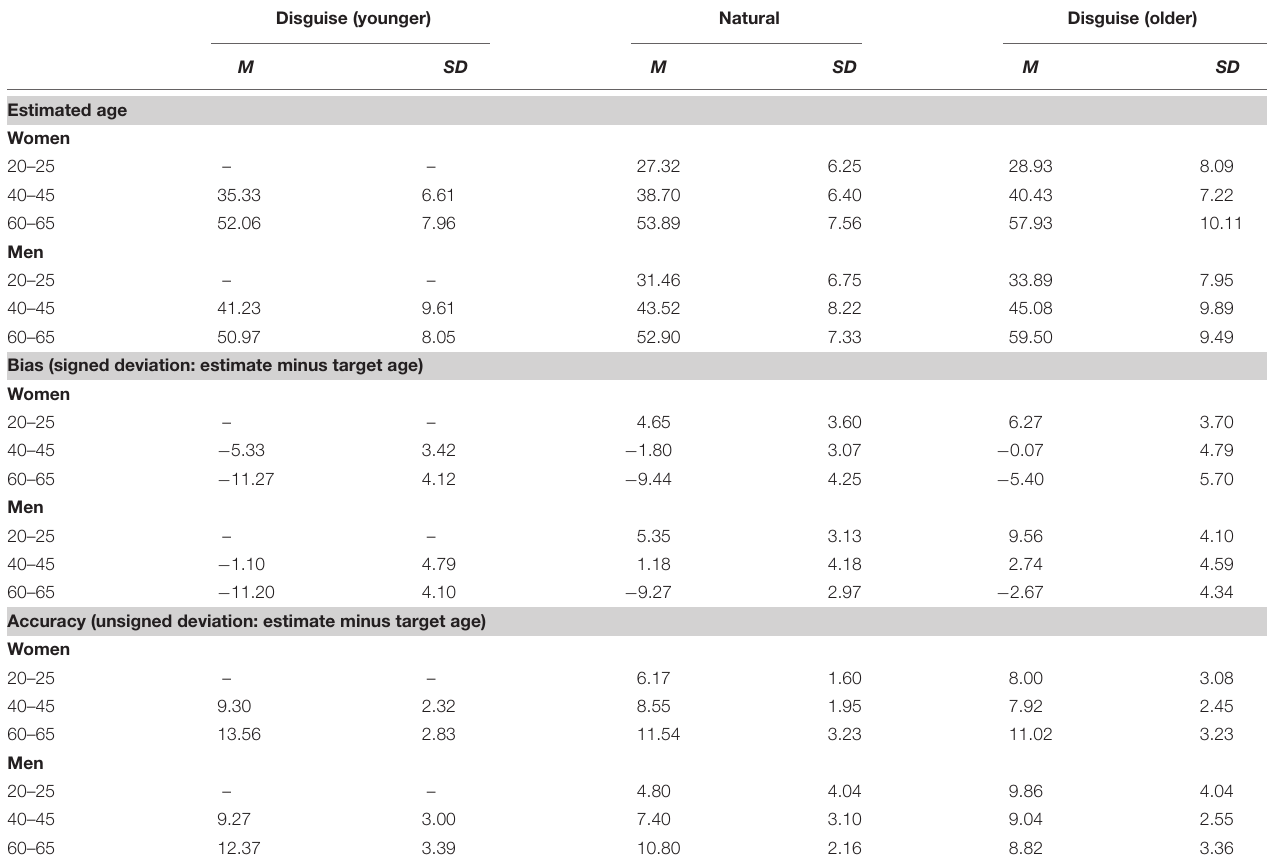
TABLE 3 | Mean and standard deviations of estimated age and accuracy (years) of women and men over disguise conditions and age groups in Study 2. Disguise (younger) Natural Disguise (older)